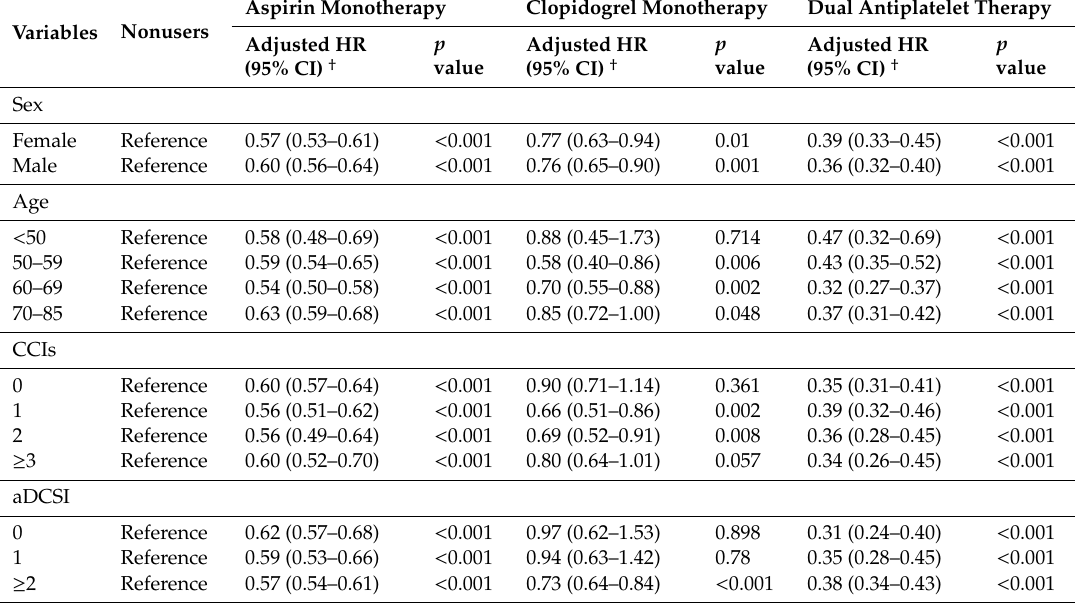
Table 3. Hazard ratio of CRC in patients with T2DM using aspirin and clopidogrel or not, stratified by sex, age, CCIs, and